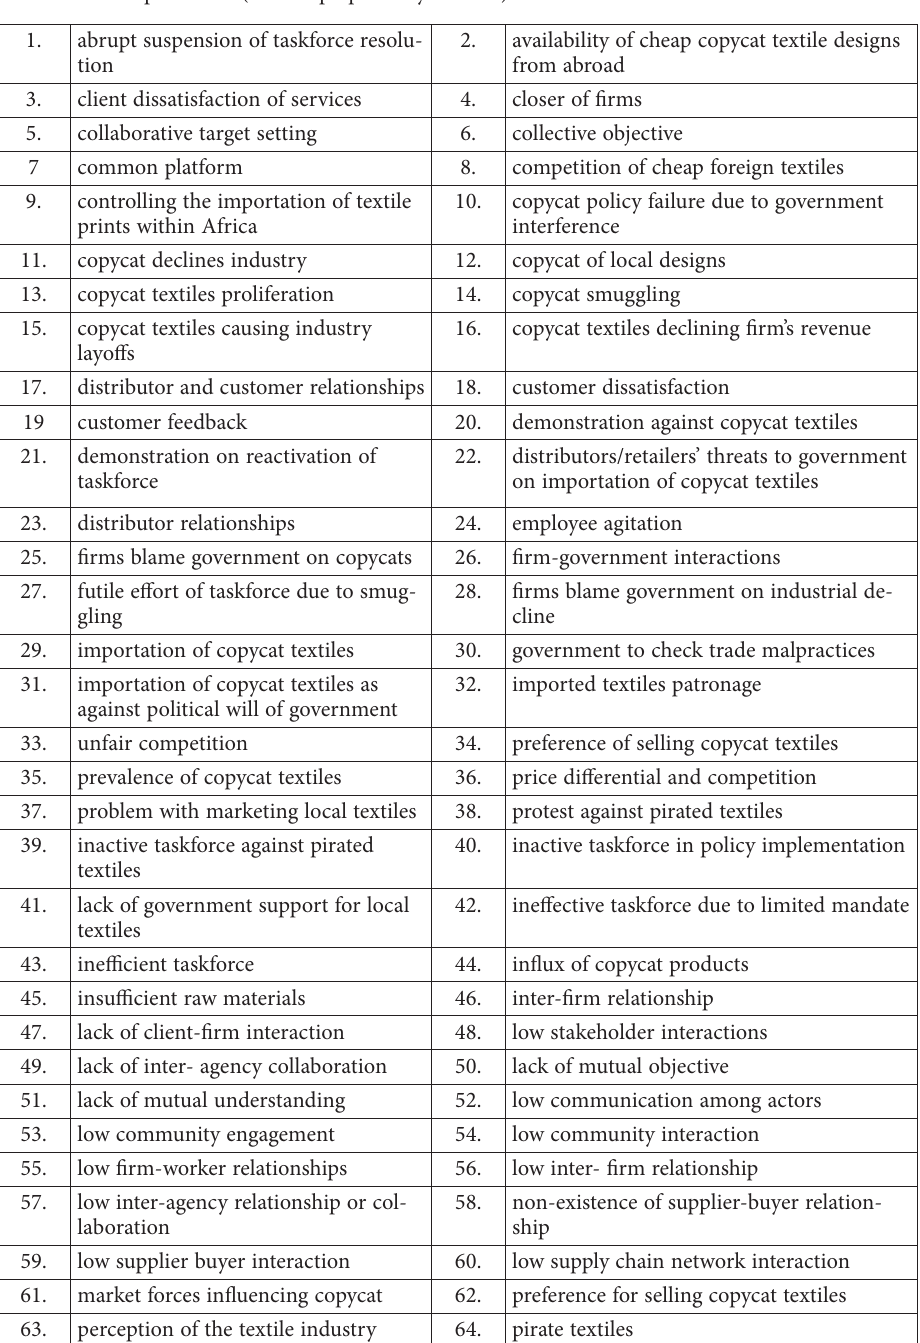
Table 3. Initial open codes (source: prepared by